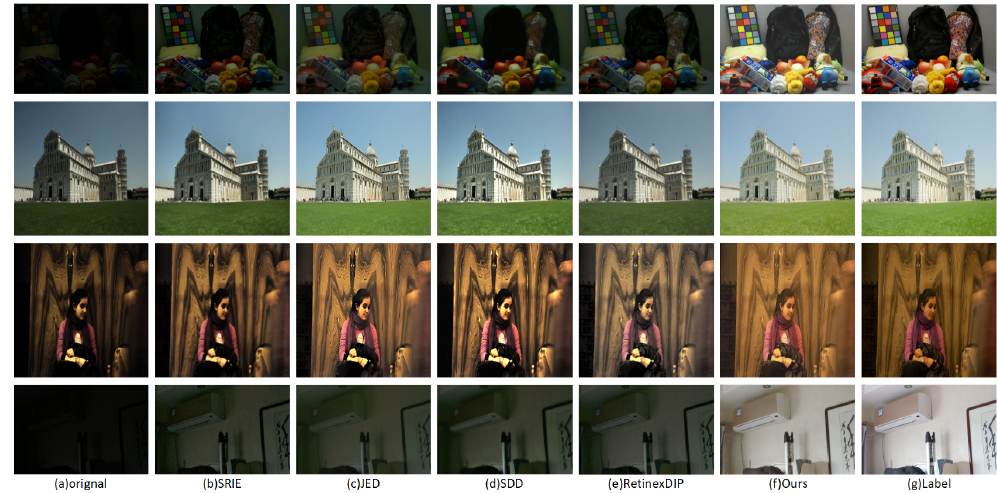
Figure 5. Example of comparison with Retinex-theory-based low-light image enhancement method on the LOL [1] dataset.